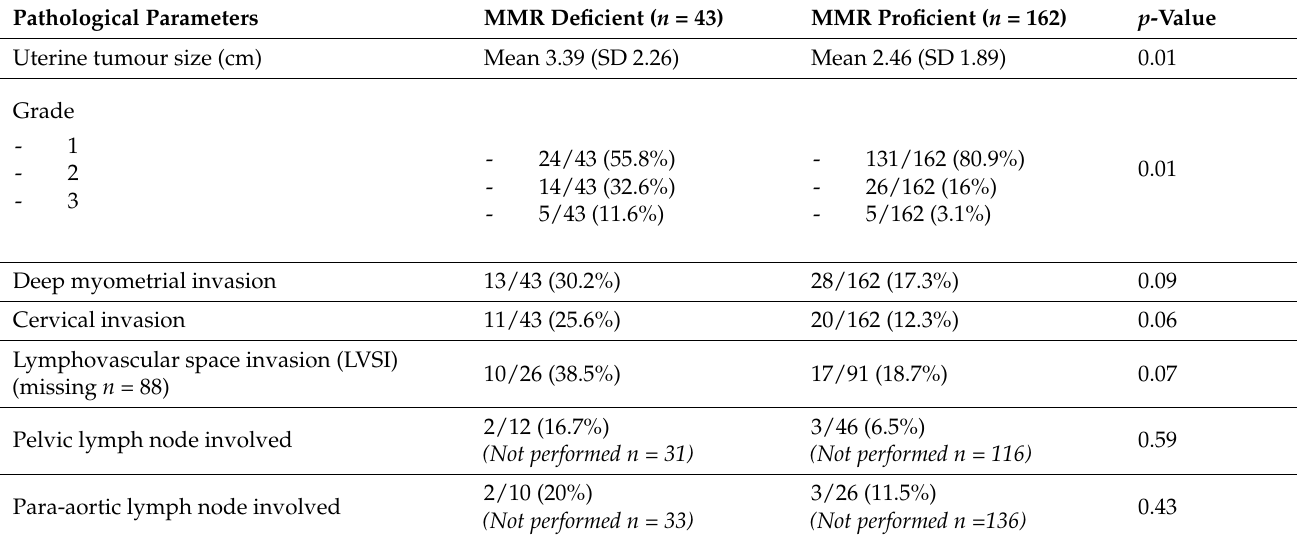
Table 3. MMR status associated with pathological